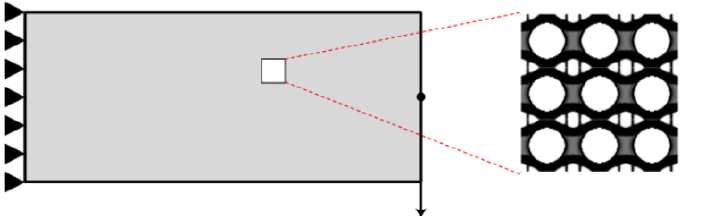
Figure 6. Optimized periodic unit cell for the cantilever beam 2 test example macro